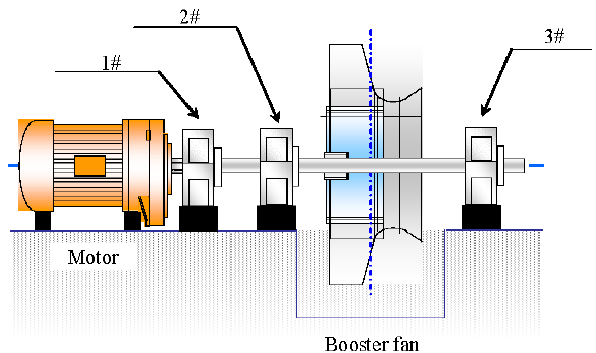
Figure 5. A sketch of the three groups of sensors.